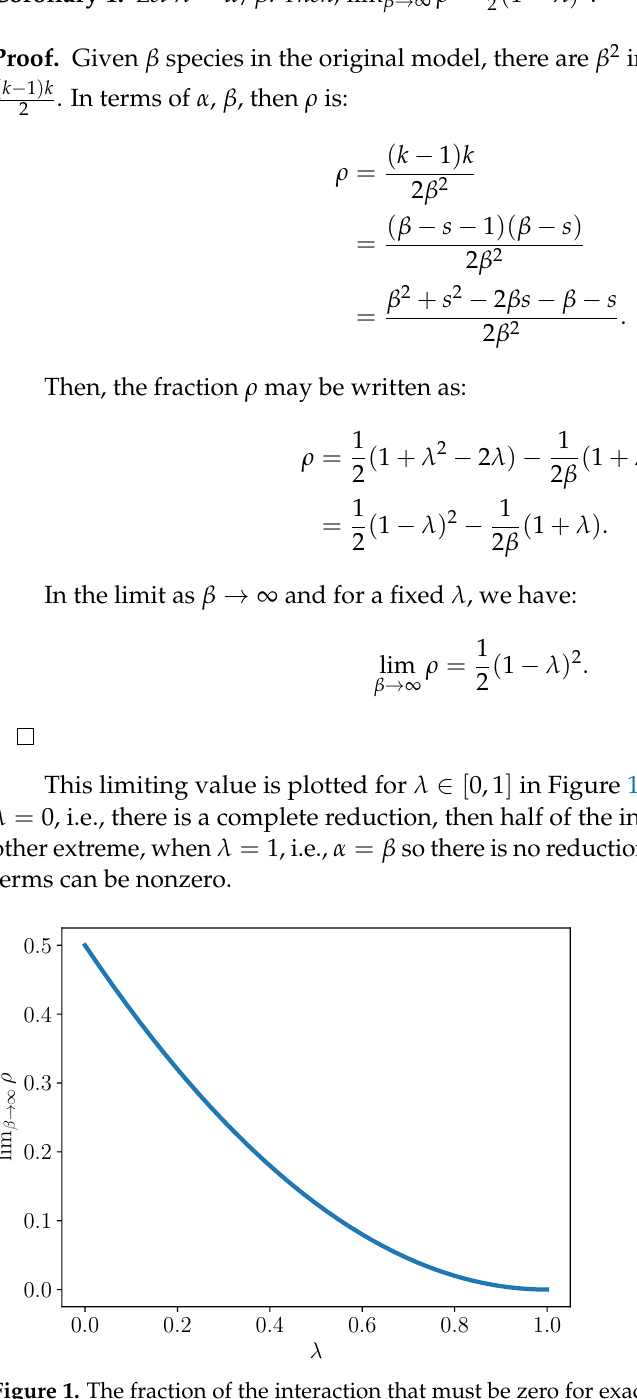
Figure 1. The fraction of the interaction that must be zero for exact reduction decreases nonlinearly β as α →